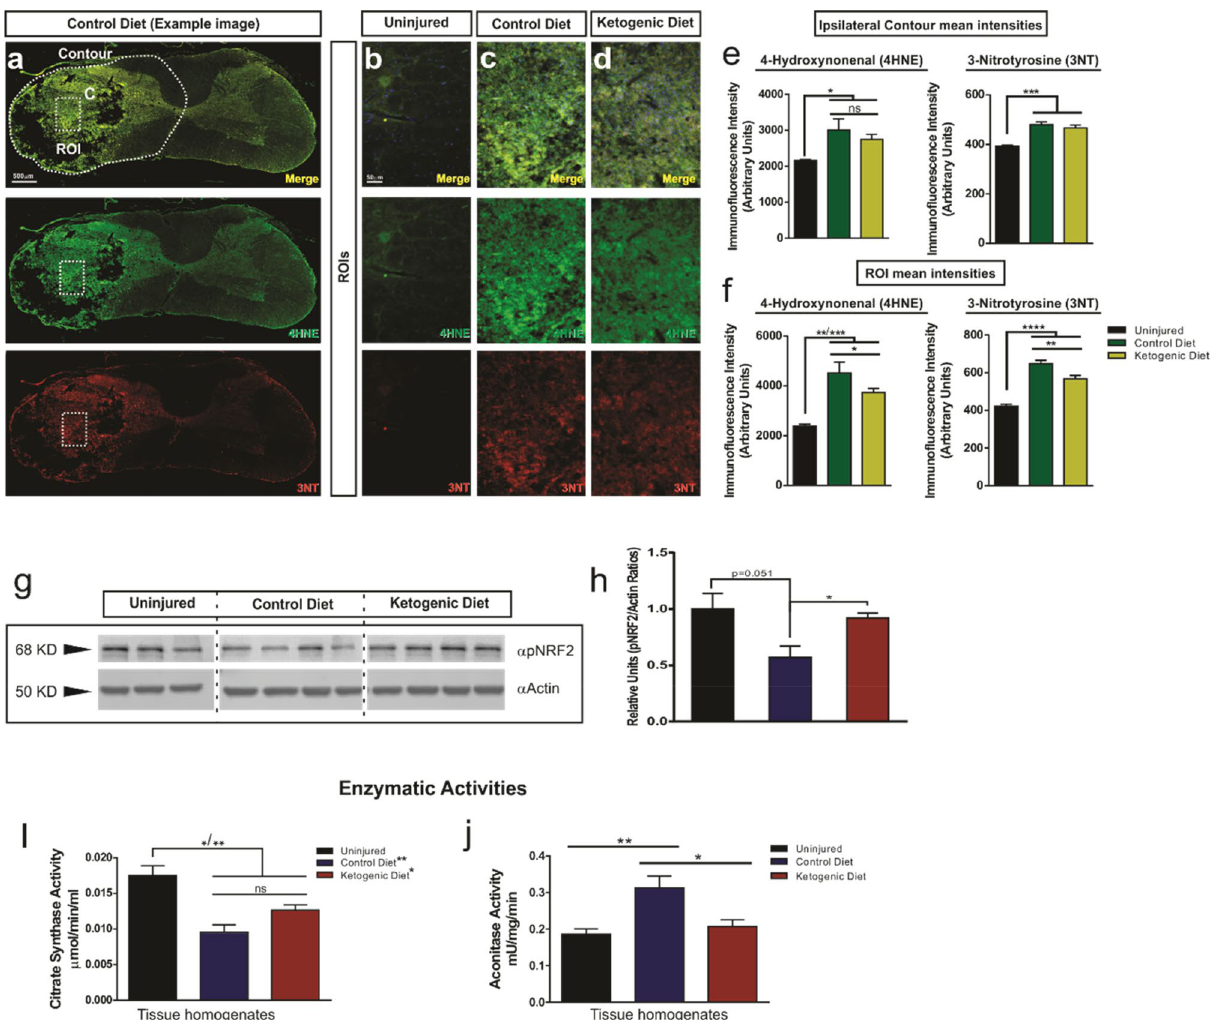
Figure 5. Effect of KD and βHB treatments on oxidative stress in vivo. ( a–f ) Double immunostainings of the spinal cord with the lipid peroxidation marker 4HNE and the protein nitration marker 3NT. Low–power example image of a cross section of an injured cord treated with CD ( a ). Dashed white outline (contour) and square (ROI) showing an example of quantified areas in ( e – f ). ( b–d ) High magnification example images of the ROIs selected form the epicenter of the injury from uninjured, and injured cords after CD or KD treatment. Intensity quantifications of the ipsilateral contour and ROI of the epicenter of the injury are shown in ( e , f ). Uninjured (n = 4), control diet, (n = 4) and ketogenic diet (n = 6); One-way ANOVA, Fisher’s LSD Post-hoc test. Values are shown as mean ± SEM . ( g , h ) Spinal cord homogenates were subjected to SDS-PAGE followed by western blot analysis using phospho-NRF2 antibody. Quantification is shown in ( h ). ( i,j ) Citrate synthase (CS) and Aconitase (AC) activities were measured in spinal cord tissue homogenates from uninjured (n = 3), control diet, (n = 4) and ketogenic diet (n = 4) treated animals. The epicenter of the injury was used for the analysis in the animals with SCI. The blots from the same gels were cropped and rearranged in the following order: Uninjured, Control Diet, Ketogenic Diet; to make them more clear and enhance reader’ understanding of the figure and the subsequent quantifications. Membranes were cut previous incubation with primary antibodies in order to optimize limited sample use . Full-length blots/gels are presented in Supplementary Fig. 5. One-way ANOVA, Fisher’s LSD Post-hoc test. Values are shown as mean ±